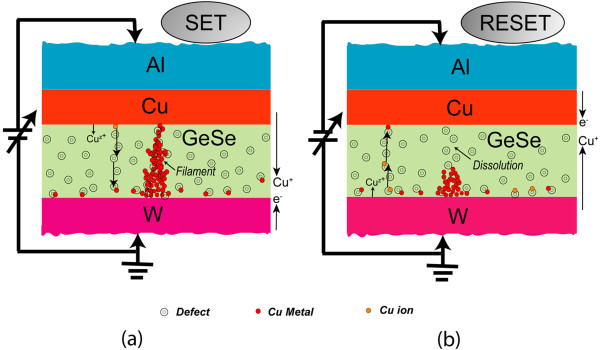
Schematic views of the filament (a) formation and (b) dissolution under SET and RESET operations.